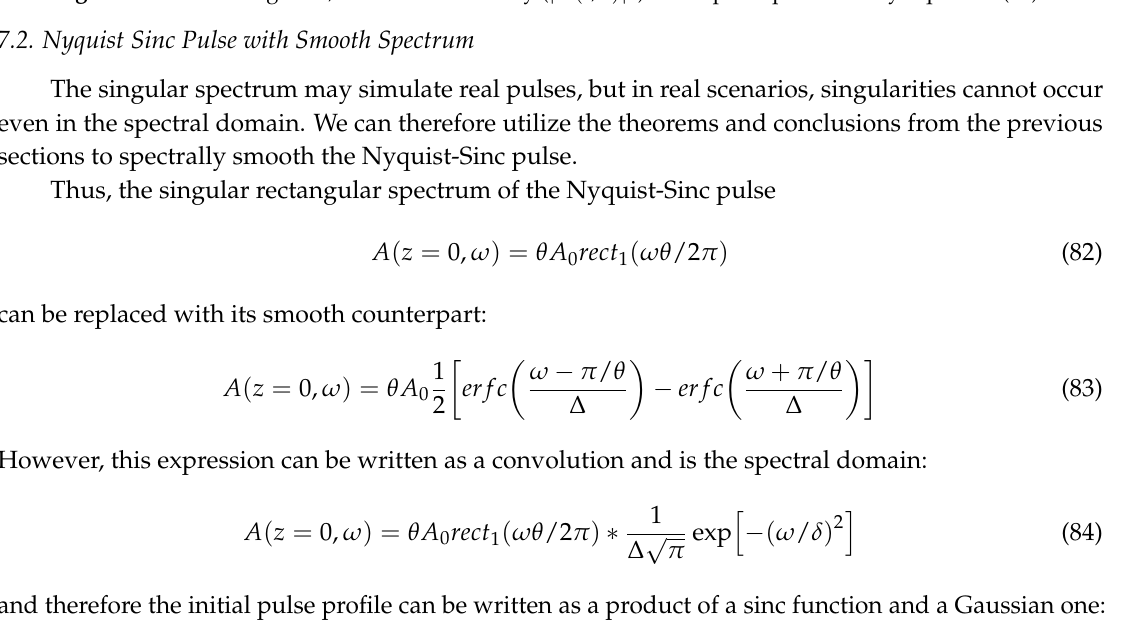
Figure 23. Same as Figure 2, but for the intensity (